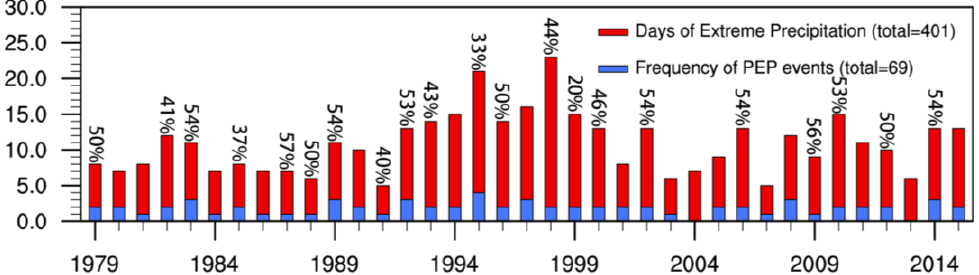
Figure 3. Days of extreme precipitation cases (red rectangle) and occurrence frequencies of PEP events (blue rectangle) within the YRV (region-1, 114–120° E, 25–30° N) in each summer (JJA) during 1979–2015. The percentage of summer extreme precipitation cases associated with the EAP/SR-C events to the total summer extreme precipitation cases are marked on each specific year.